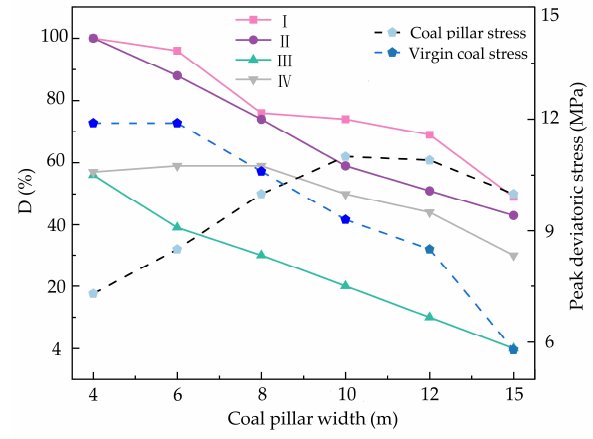
Figure 9. Distribution of the plasticization factor in subdivisions.